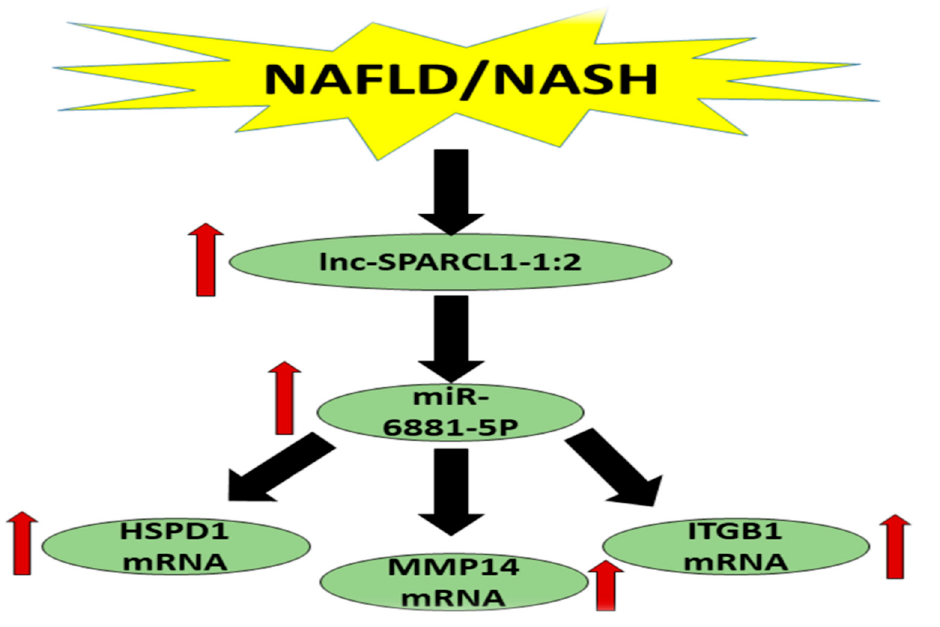
Figure 5. Schematic presentation of the study findings.